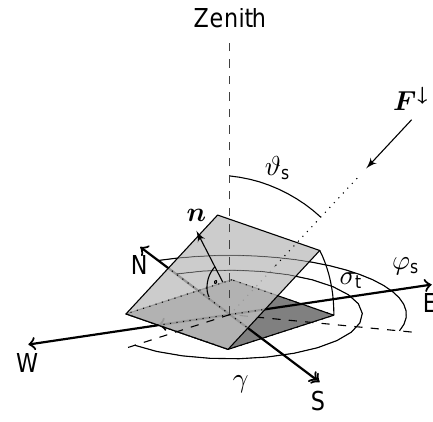
Figure 3. Geometric account of a tilted